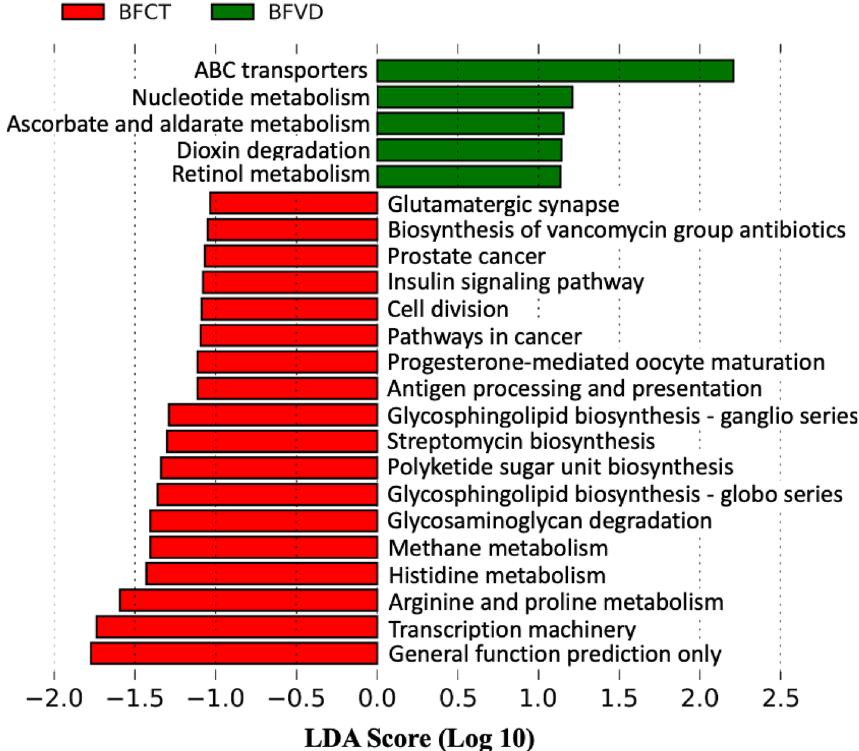
Figure 5. Inference of metagenomic functional content of gut microbiota from breastfed infants with vitamin D supplementation.